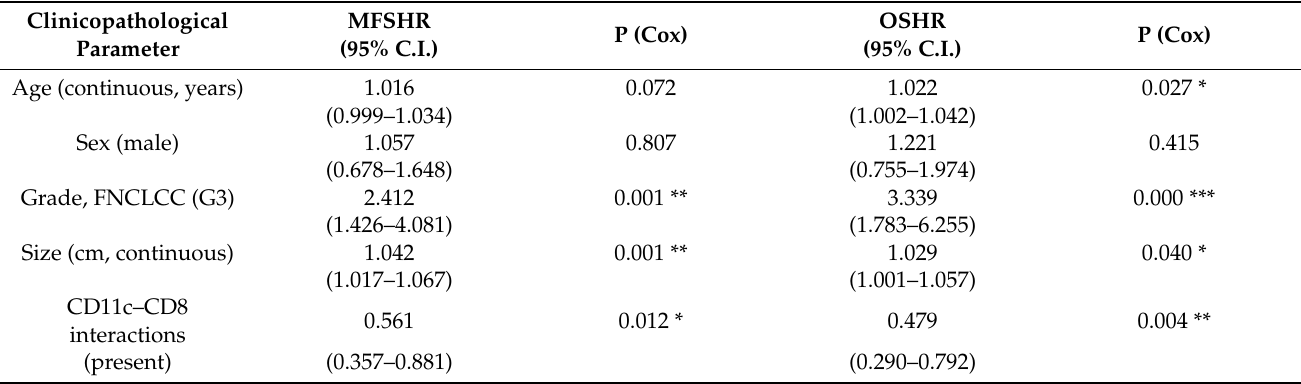
Table 2. Multivariable analysis (cox-regression) of clinicopathological features and survival in the Karolinska STS cohort.